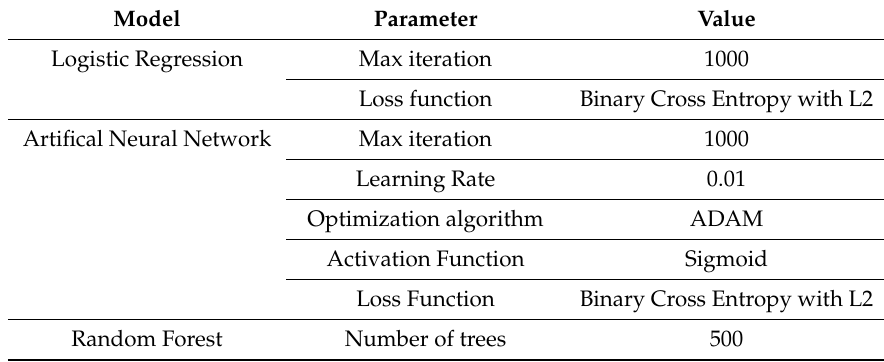
Table 4. The model parameters used for ANN, logistic regression (LR), and random forest (RF)